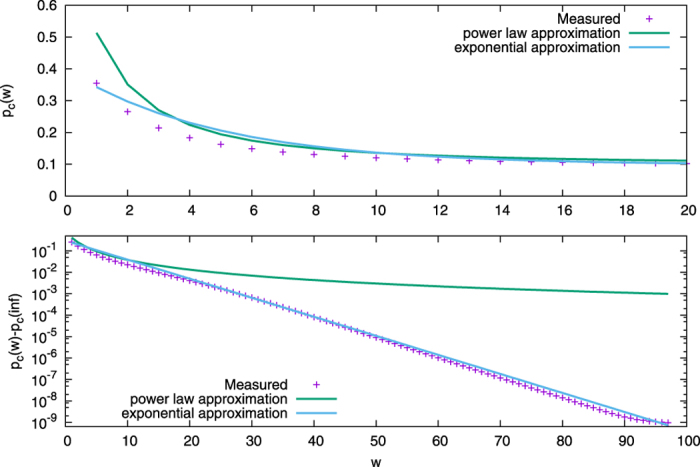
The critical value function of the waning commitment naming game.The top plot shows critical values of the fraction of committed agents with different commitment strengths. The bottom plot shows the differences between pc(w) and pc(∞). The critical value function is an exponential one especially when the commitment strength is large.